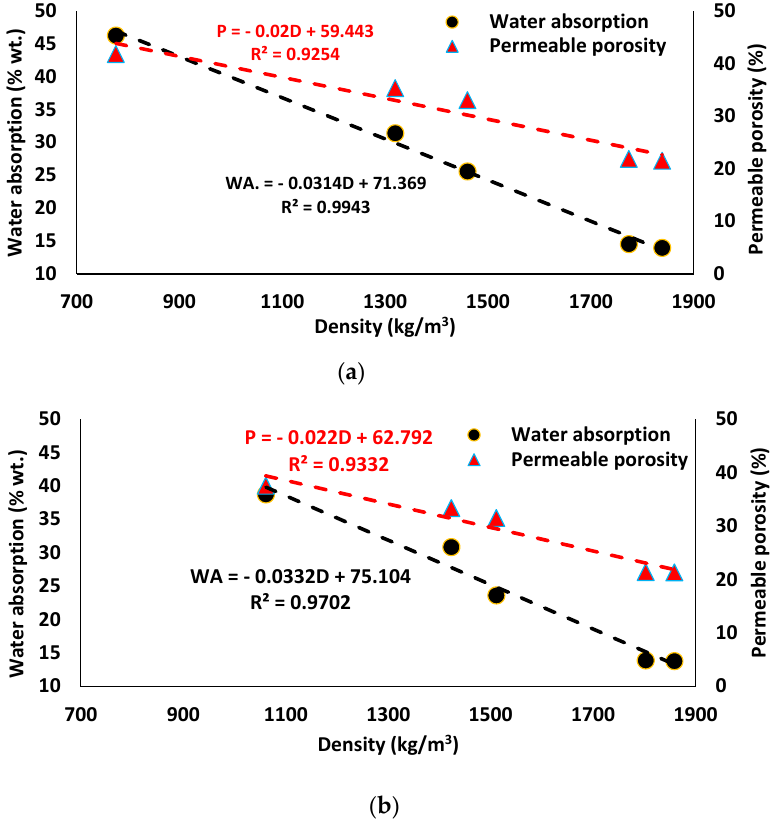
Figure 11. The relationship between water absorption, permeable porosity, and density of mix compositions: ( a ) SW50/GW10; ( b ) SW30/GW30.